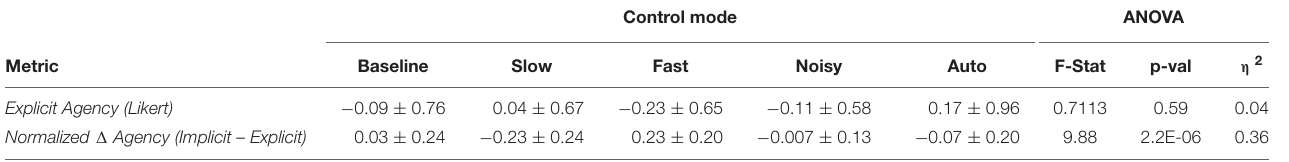
FIGURE 7 | Comparing mean agency from IMPLICIT time-interval estimates (in ms) versus EXPLICIT survey responses (average Likert score) for each control mode. (A) Positive implicit agency is indicated as underestimation of actual time-intervals. (B) Positive explicit agency is indicated by level of agreement that the displayed control of the virtual hand reflects participant intent. Survey Likert scores given as: - 2 = Strongly Disagree, − 1, Disagree, 0 = Neutral, 1 = Agree, 2 = Strongly Agree. (C) Implicit versus explicit agency across subjects and control modes after self-normalizing for mean to equal zero and range over [–1, 1]. F-stat for regression is 4.62 with p = 0.035. (D) Relative shift shift from explicit to implicit shown for each control mode. TABLE 2A | Mean value comparisons for implicit and explicit agency across control modes. Control mode ANOVA